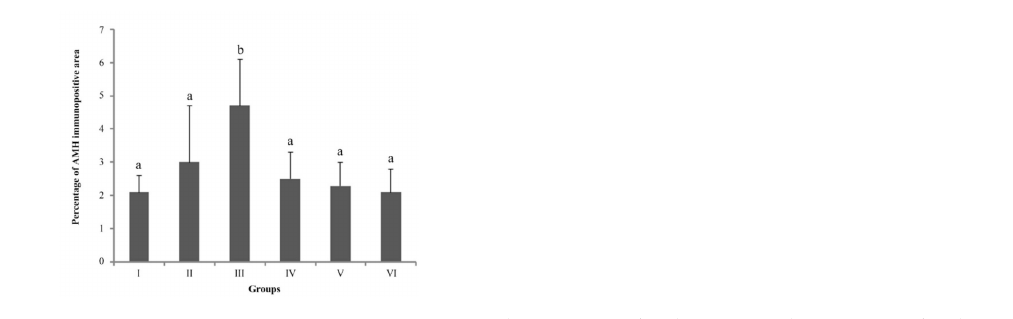
Figure 6. Ovarian AMH expression. Group I ( n = 3, 24–29 days), Group II ( n = 8, 32–40 days), Group III ( n = 4, 41–46 days), Group IV ( n = 6, 53–61 days), Group V ( n = 6, interestrus), Group VI ( n = 6, estrus). a,b p < 0.05.